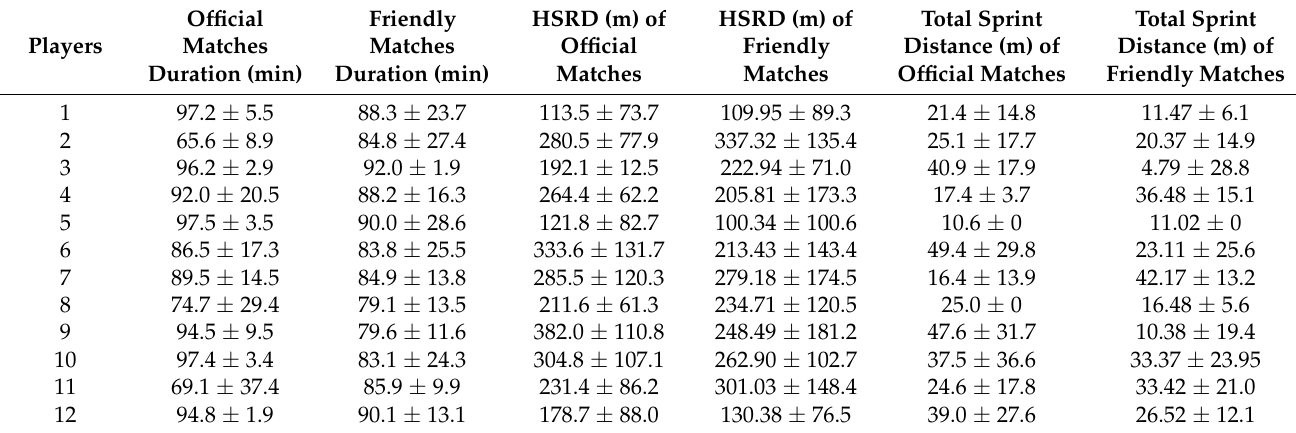
Table 1. Average and standard deviation of match duration and running distances by each player during official and friendly